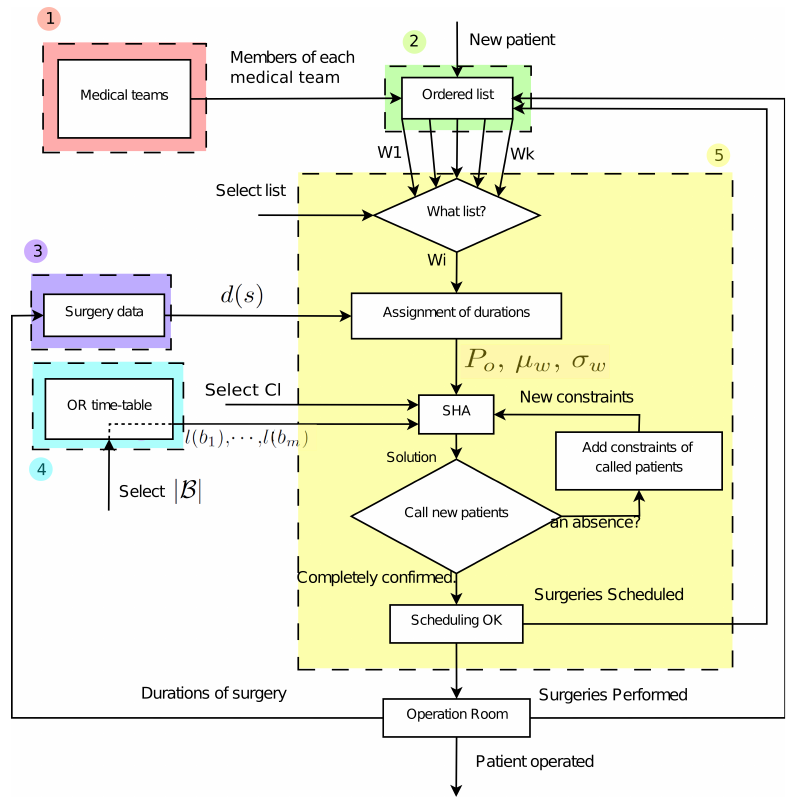
Figure 1. Flowchart of the DSS. The steps form the moment when a patient arrives until she/he is surgically operated are shown. The discontinuous colored boxes reference the five main panels included in the developed software tool: (1) Medical teams; (2) Patients; (3) Surgeries; (4) OR timetable; and (5)